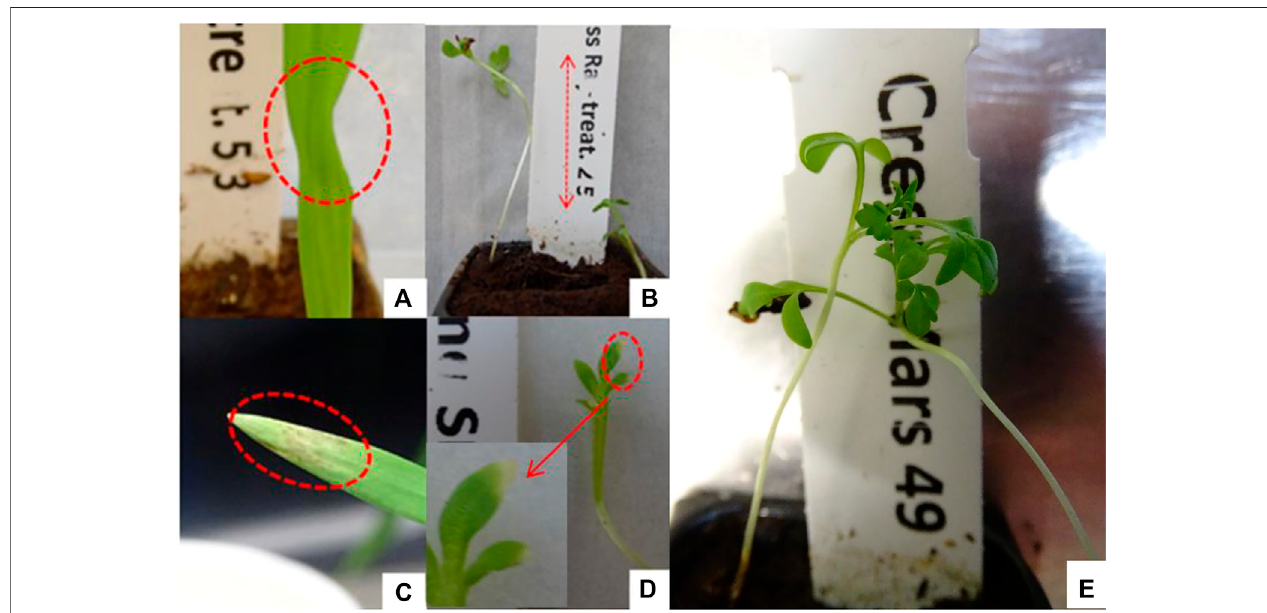
FIGURE3| Picturesofindividualplantsshowingtheobservedmalformationsinrye (A) andcress (B) andtheabnormalcoloringofleavesforbothrye (C) andcress (D) . (E) gives ‘ normal ’ non-irradiated cress plants on Mars regolith simulant.